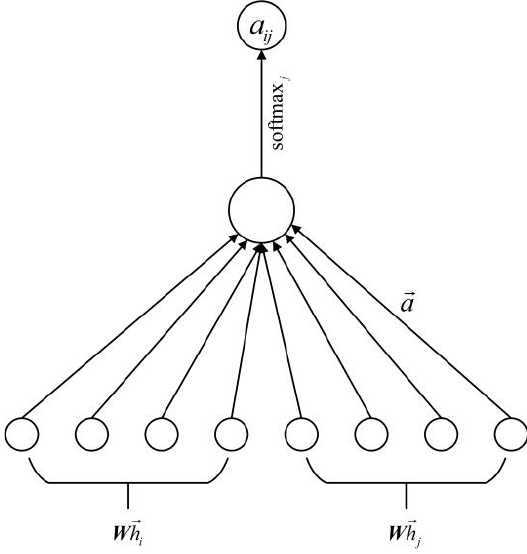
Figure 3. Representation of the attention layer.